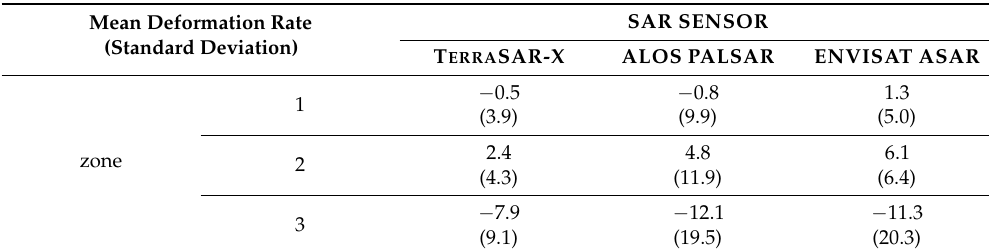
Table 3. Deformation rates of the three zones (unit: